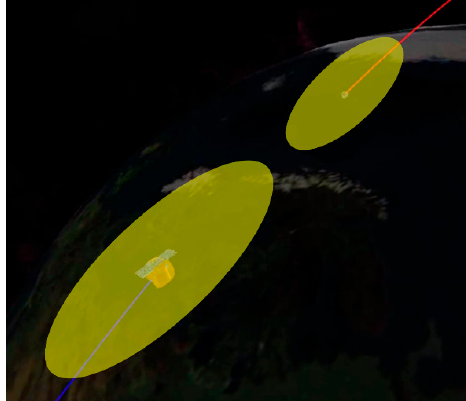
Figure 2. 3D Visualization of risk assessment analysis tool: